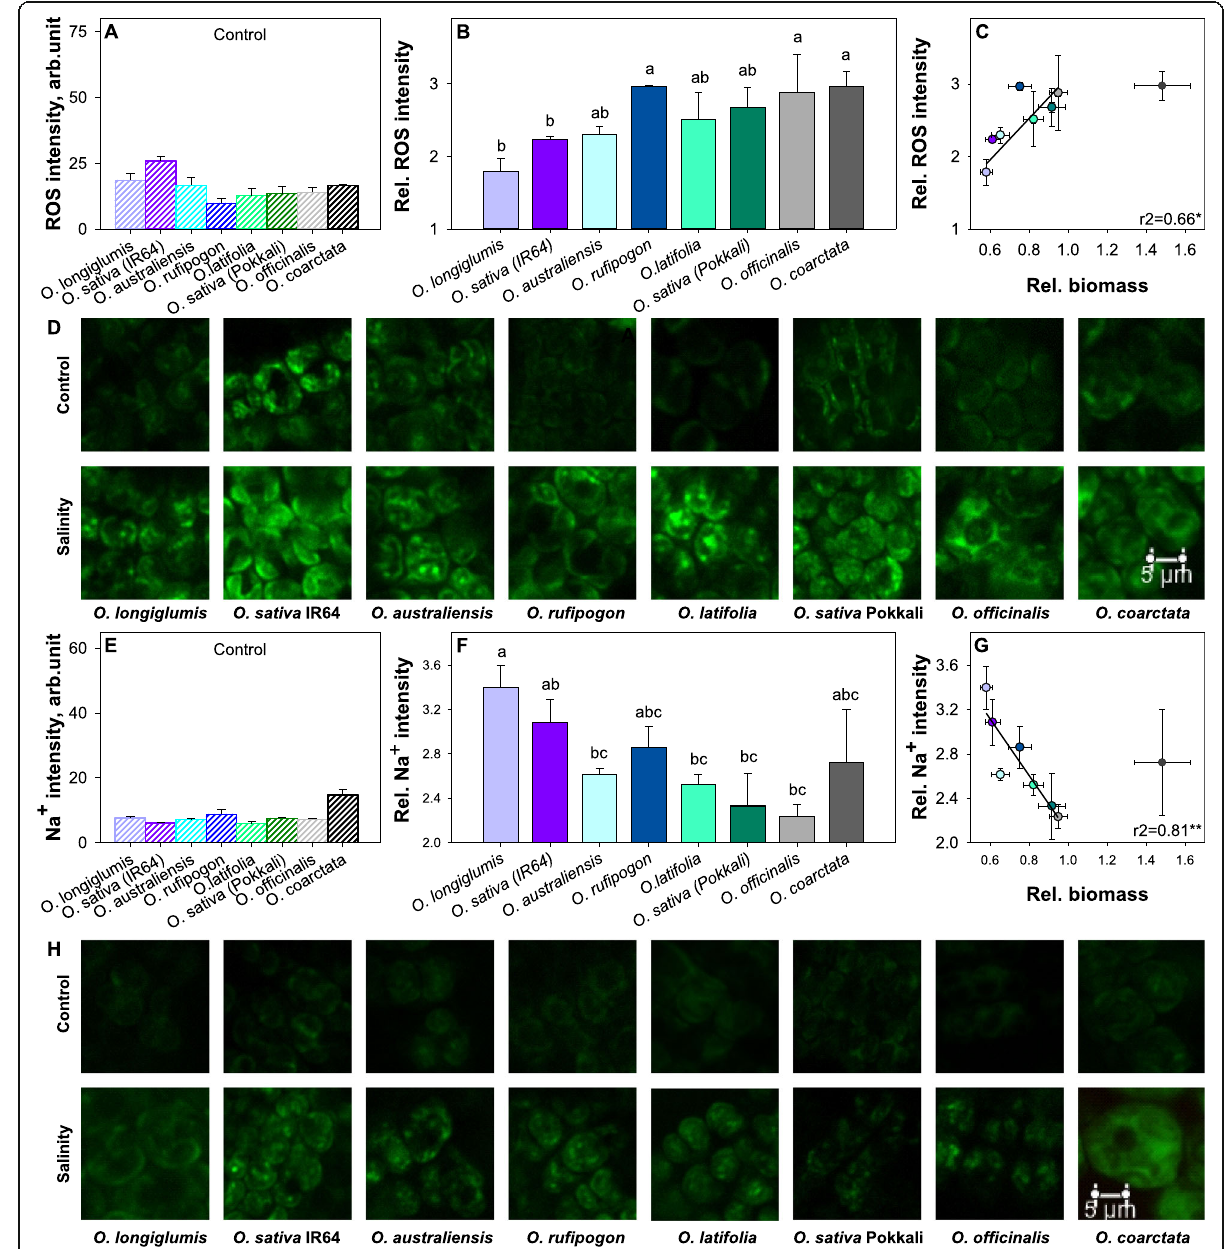
Fig. 6 Linking salinity tolerance of wild and cultivated rice to accumulation of reactive oxygen species (ROS) and Na + in leaf mesophyll cells after 42 days of 100 mM NaCl treatment: ( A & E ) ROS & Na + fluorescence in the mesophyll of control plants; ( B & F ) relative ROS and Na + fluorescence in the mesophyll of salinity-stressed and control plants; ( C & G ) Pearson correlation of relative ROS production and Na + fluorescence and relative biomass; ( D & H ) representative image of ROS and Na + in mesophyll. The scale bars = 5 μ m. Data are means and the error bars indicate the standard errors. Different lowercase letters indicate significant differences at P < 0.05 for each Duncan